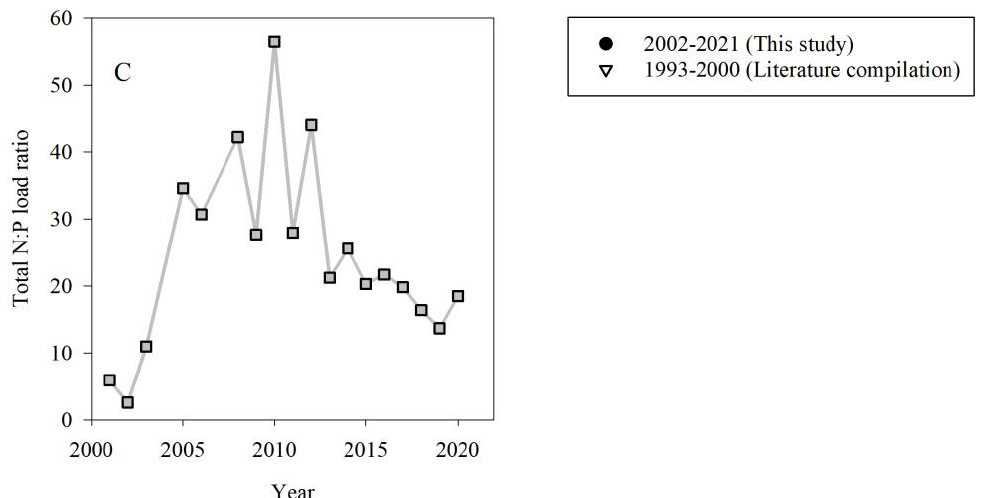
Figure 5. Relationship between NO 2 − + NO 3 − ( A ) or DIN ( B ) vs. PO 43 − concentrations in surface water at the Kishon harbor during this study, 2002–2021 (black circle) and measurements performed during 1993–2000 (white triangles, [24,25]). The linear regression slopes for this study and 1993–2000 in panel A are 17.3 and 2.6, and in panel B are 11.3 (or 17.6 excluding the high anomalous value) and 4.6, respectively. The anthropogenic N:P load ratio is shown in panel ( C ) (grey square,